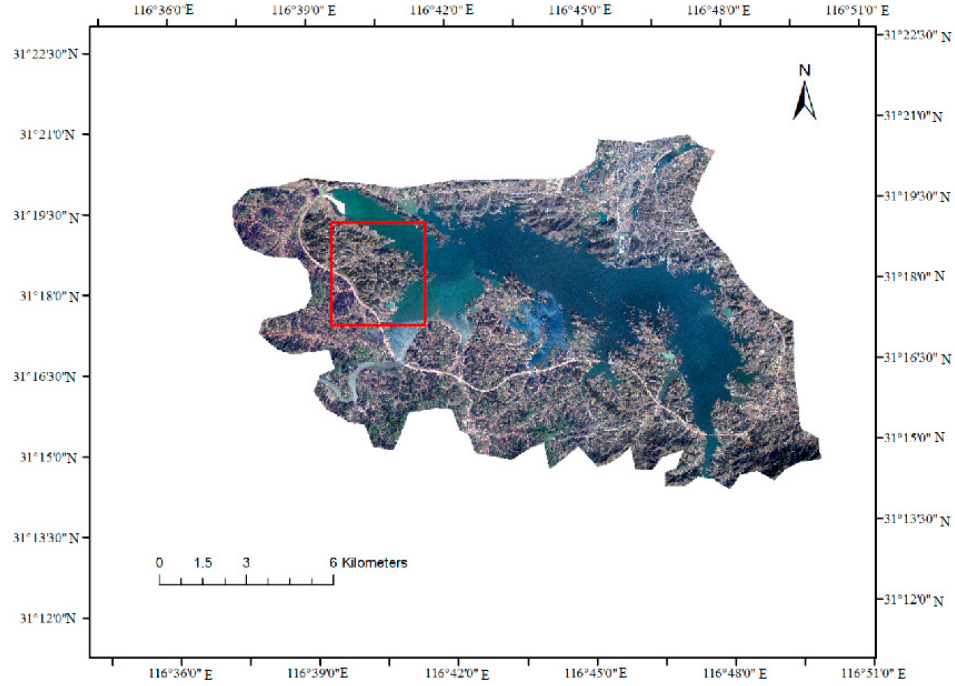
Figure 4. Wanfoshan–Longhekou Reservoir (Wanfo Lake) Scenic Area in Shucheng County, Lu’an City, Anhui Province (Beijing No. 2).